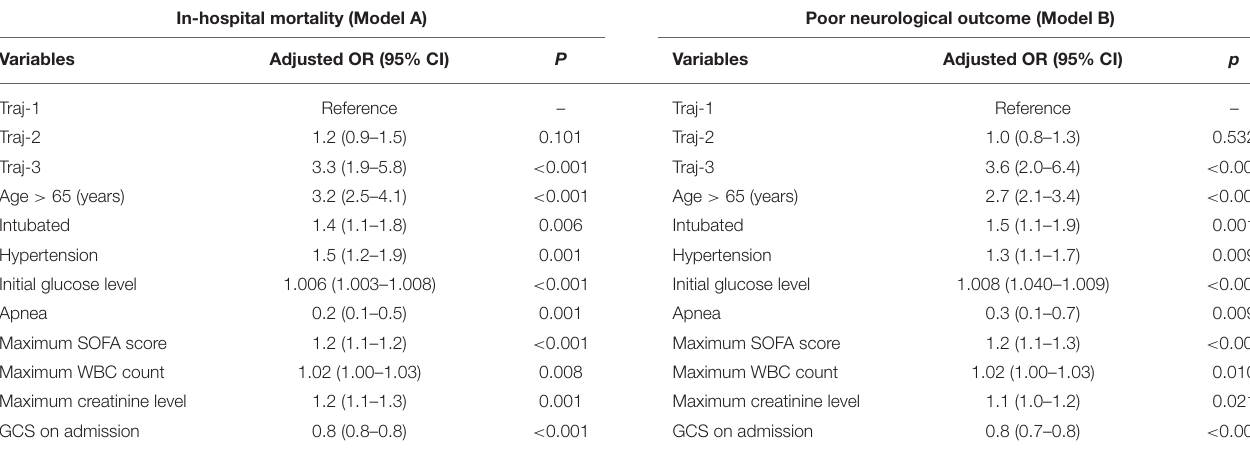
TABLE 4 | Associations between the partial pressure of oxygen trajectory and prognosis in multivariable logistic regression